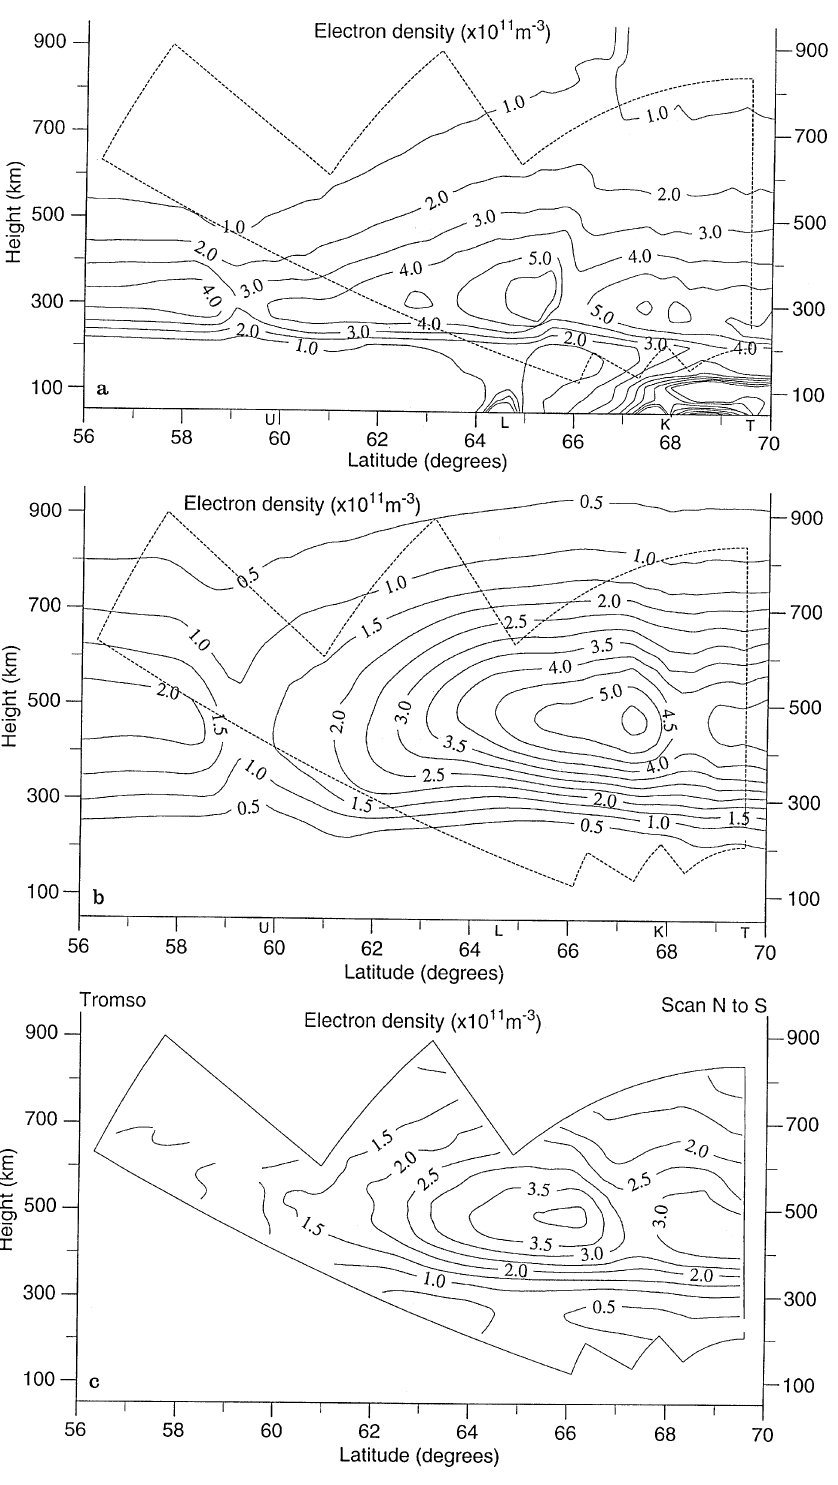
Fig. 4. a Tomographic image of electron density for a satellite pass at 2058 UT on 23 March 1992 with background iono- sphere based on the USU model (taken from Kersley et al ., 1993); b tomographic image of electron density for the same pass with background ionosphere based on latest technique which requires no addi- tional a priori information (see text); c electron densities measured by EISCAT using SP-UK-TOMO between 2050 and 2109 UT on 23 March